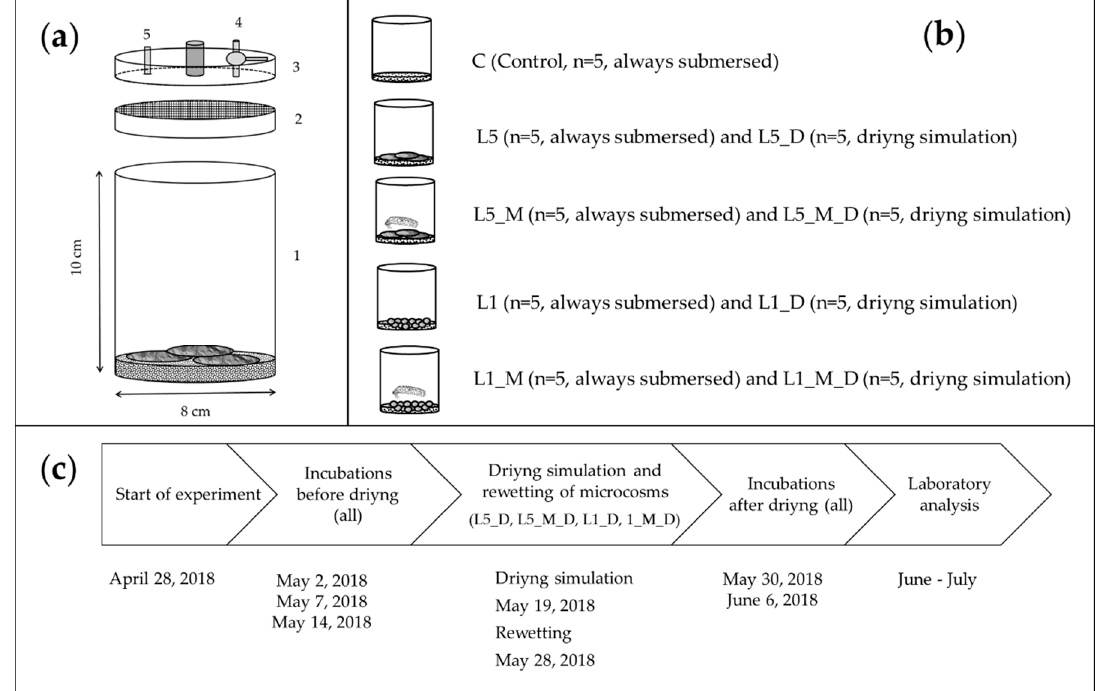
Figure 1. Microcosms set up ( a ), experimental design ( b ) and sequence of actions ( c ). The microcosms used in this experiment were made with opaque PVC (a1). The experimental design consisted of nine treatments, each with five replicates, with various combinations of leaves and macrofauna (b). During maintenance in the tank, microcosms were closed with a lid provided with a net (a2) to allow water exchange between the inner microcosms and the tank. Such lid was replaced with a gas-tight lid (a3) during short-term dark measurements of oxygen and nutrients. The incubation lid was provided with a sampling port (a4) and a compensation valve (a5). Besides control microcosms, incubated to correct fluxes for processes in the water column, we tested four combinations of small and large leaves with or without macrofauna (b). These combinations became eight during the experiment (c) as half of the replicates for each condition underwent a drying simulation.